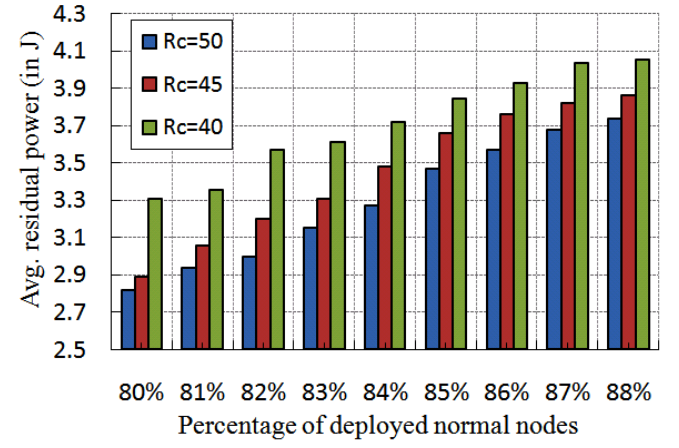
Figure 11. Average residual power for different number of beacon nodes.